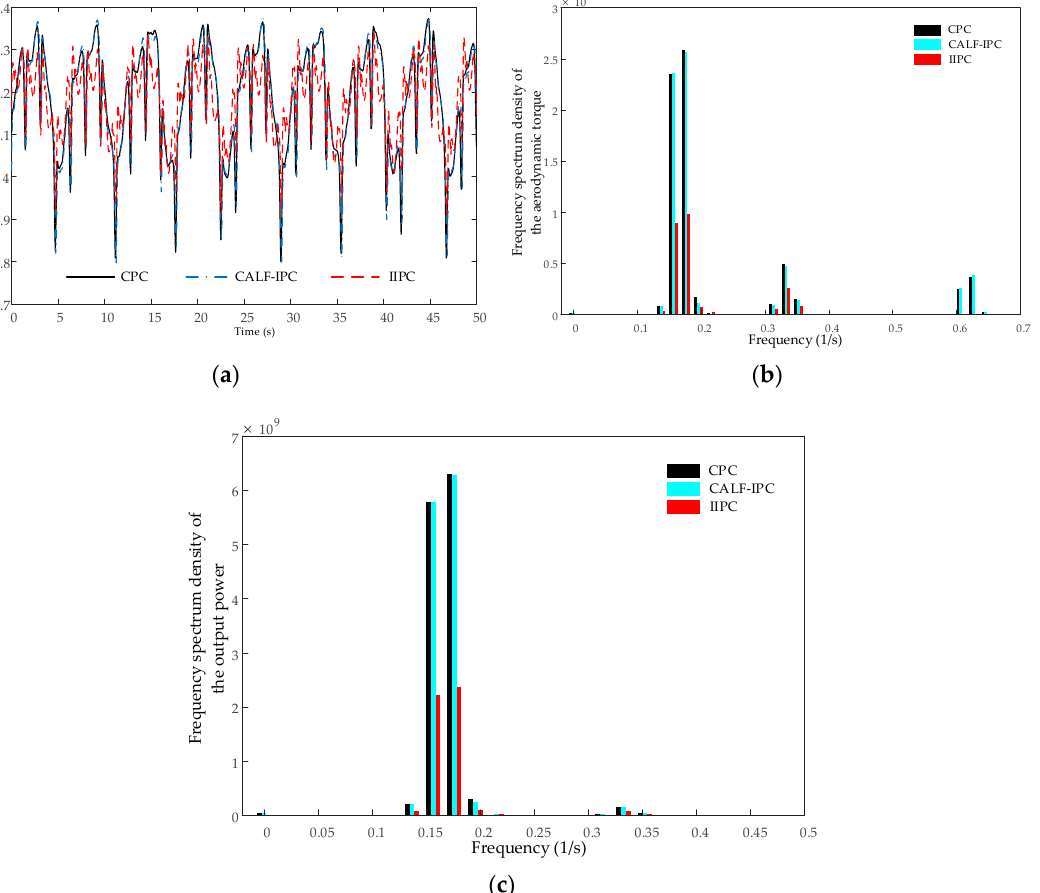
Figure 13. Time domain and frequency domain results of aerodynamic torque and output power under different control: ( a ) Curves of the aerodynamic torque; ( b ) Frequency spectrum density of the aerodynamic torque; ( c ) Frequency spectrum density of the output power.